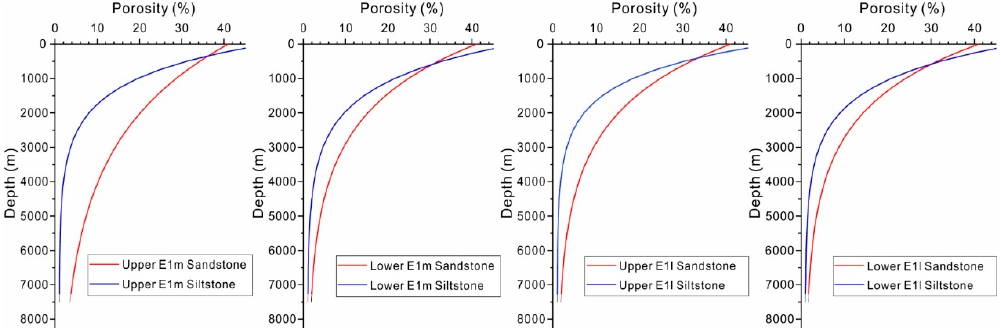
Figure 6. The calibrated porosity versus depth curve using Athy’s Law for the sandstone and siltstone in E 1 m and E 1 l (the curves for upper and lower layers are separated).